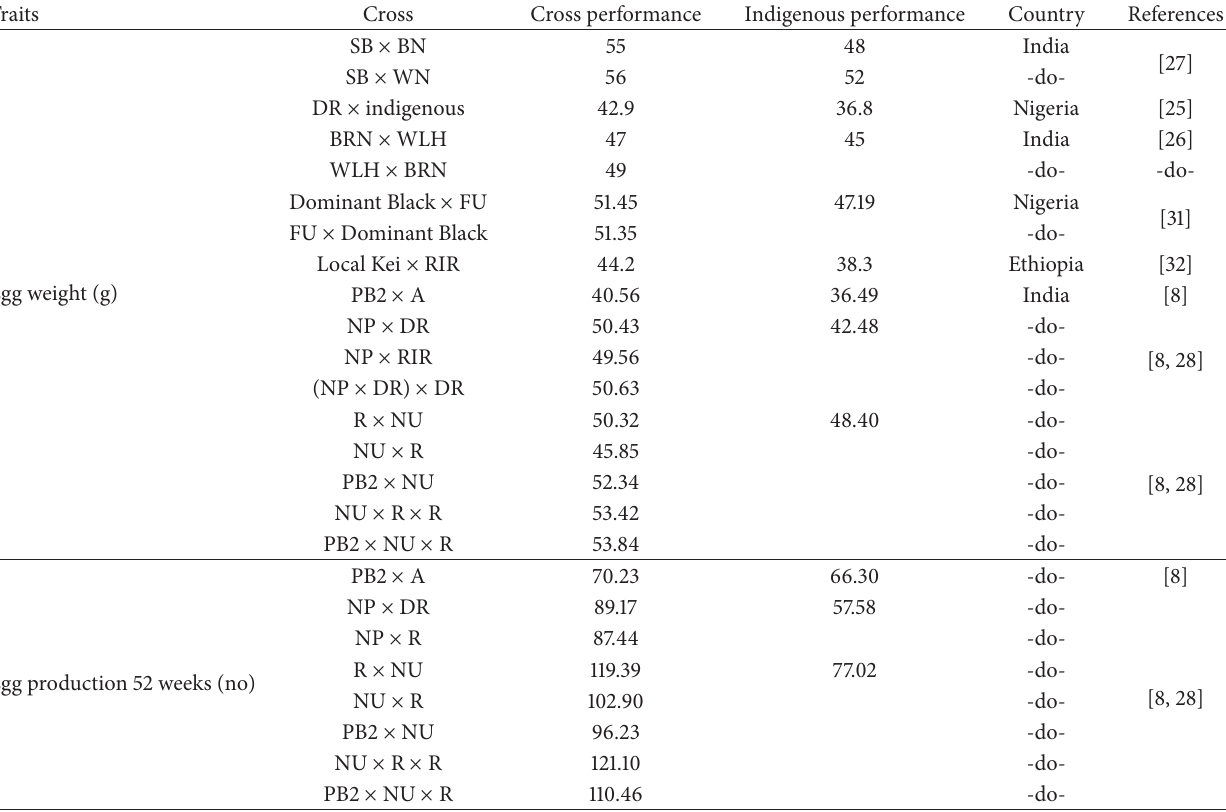
Table 4: Effect of crossbreeding using indigenous birds with respect to egg weight and egg production up to 52 weeks of age.